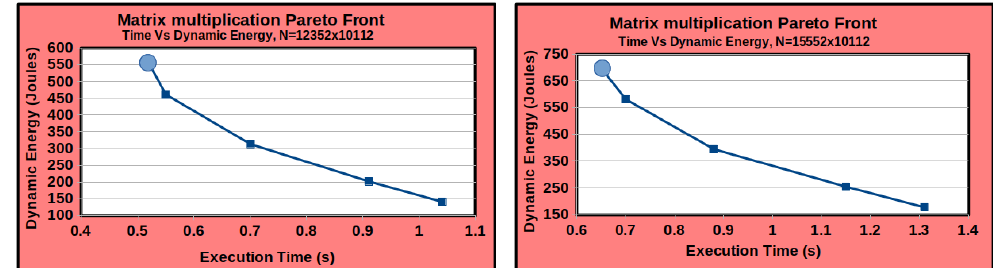
Figure A2. Pareto fronts for the matrix multiplication application executing on the heterogeneous platform (Figure 1) for two workloads. Each Pareto front contains four linear